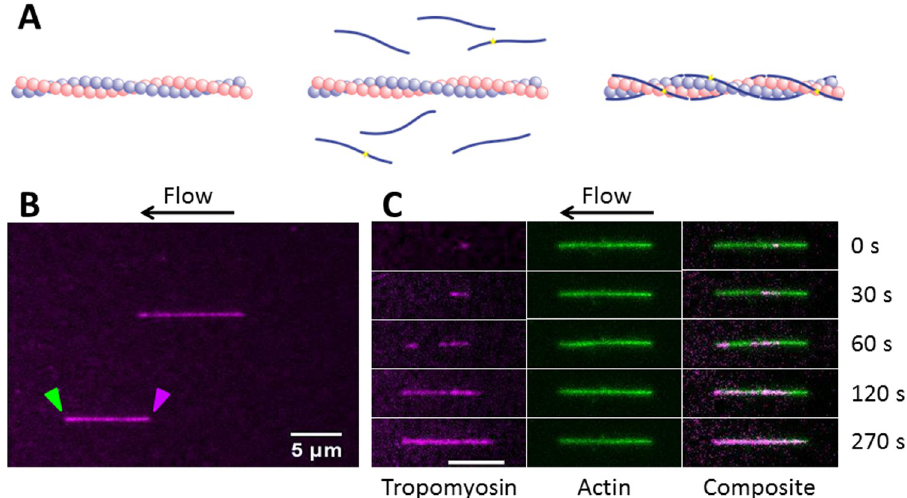
Fig 2. Association of tropomyosin Tpm1.1 to actin filaments. (A) Schematic of Tpm1.1 molecules binding to actin filament. (B) Actin filaments decorated with AF647-Tpm1.1 under the flow in the microfluidic channel. Green and magenta arrowheads indicate barbed end and pointed end of the actin filament, respectively. (C) Snapshots of a single actin filament from a two colour TIRF time lapse image stack show binding of Tpm1.1 to phalloidin-AF488 labelled pre-formed actin filament. Data shown in Fig 2B and C were for Tpm1.1 at 62.5nM at 92nm/pixel resolution and 1Hz acquisition speed. Scale bar, 5 μ